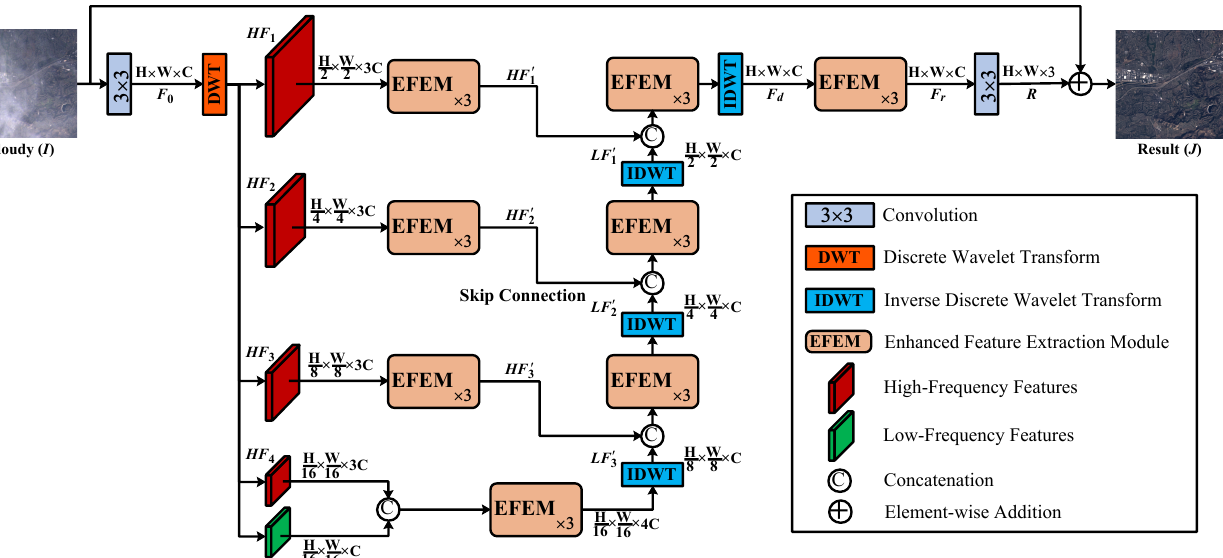
Figure 2. The overall framework of the proposed